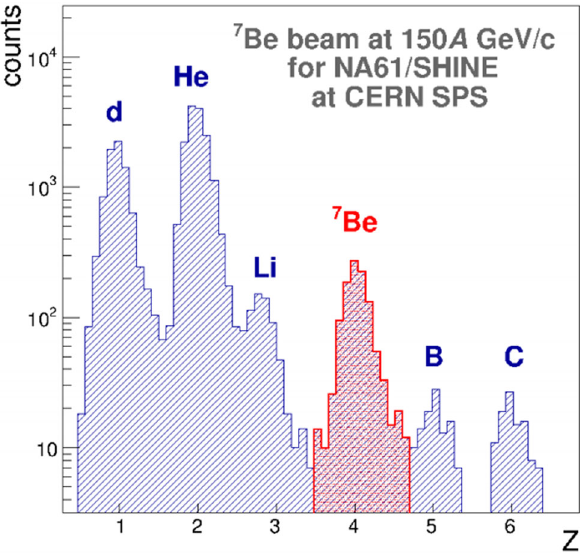
Fig. 3 Charge of the beam particles measured by the Z detector inelasticcollisionsatbeammomentaof19 A and150 A GeV / c ,